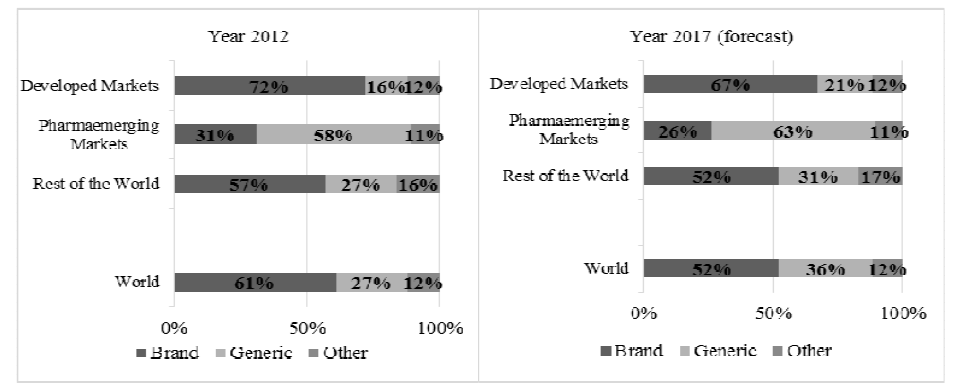
Figure 5: Generic and Branded Drug Shares by Area. Year